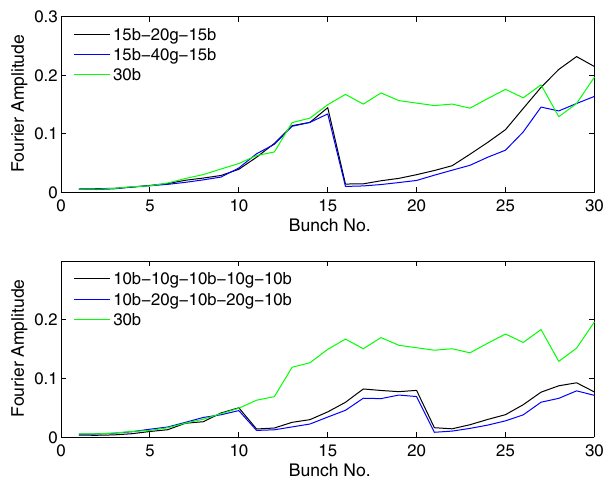
FIG. 12. Amplitude at vertical tune, obtained from FFT of vertical bunch motion (in mm), as a function of bunch number for different bunch patterns. In the notation used in the legends, “ b ” refers to a bunch, and “ g ” refers to a gap.